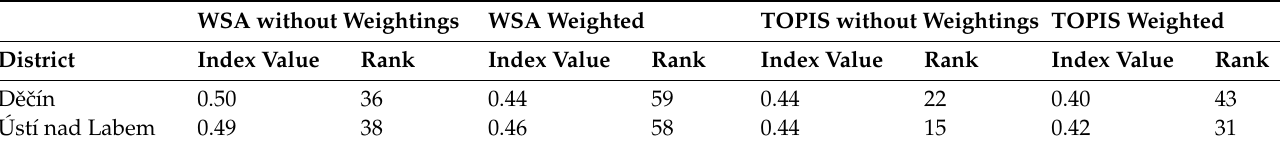
Table 6. Comparison of changes in Health Index values and ranking of the districts of Dˇeˇc í n and Ú st í nad Labem. WSA without Weightings WSA Weighted TOPIS without Weightings TOPIS